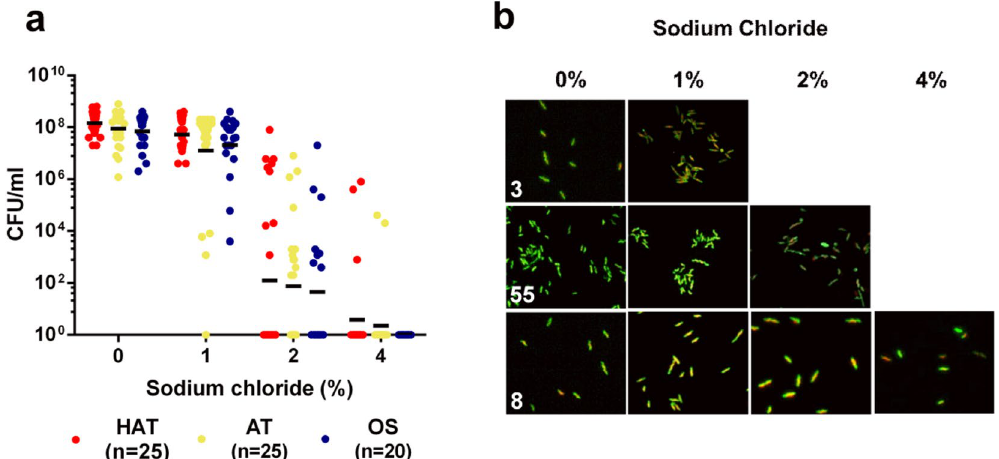
Figure 5. Osmotolerance in 70 strains of C . jejuni from retail chicken and morphological changes under osmotic stress. ( a ) The viability of 70 strains of C . jejuni under different NaCl concentrations (1, 2, and 4%). Solid horizontal lines indicate the mean values. ( b ) Morphological changes in C . jejuni strains under osmotic stress. C . jejuni was stained with SYTO9 and propidium iodine, and the strain numbers are indicated in the figure. The experiments were repeated three times. Two-way ANOVA was used for statistical